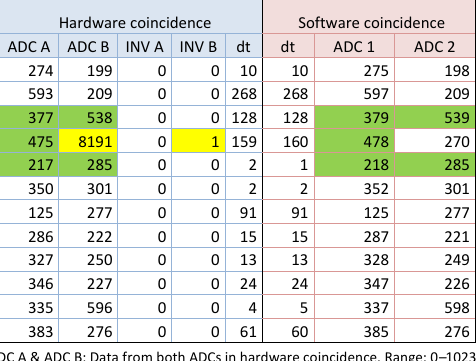
Figure 15. Data analysis. We can see the same data acquired in hardware coincidence and software coincidence columns, with an insignificant difference between values, which is due to ADC con- version. Sometimes, a conversion error is produced in an ADC, the invalid line is activated and the ADC data are out of range. That is what happens in the fourth row. In yellow, the invalid i2 acti- vated (1) and the ADC2 data value (out of range = 8191). These are not valid data. Although the hardware has detected the coincidence, these data are not registered in the normal acquisition process be- cause the Data Ready signal is not activated. In this fragment there would be one less data in hardware coincidence. This situation is in- herent to ADC’s operation, and it has nothing to do with hardware or software coincidence.